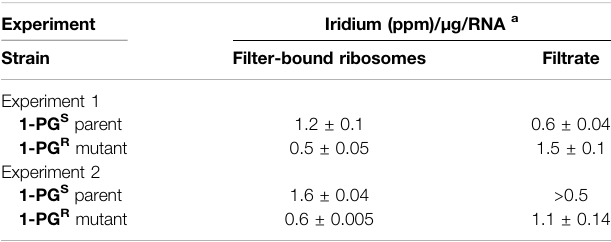
TABLE 3 | Iridium-binding of fi lter-bound ribosomes of 1-PG S M. smegmatis parent and 1-PG R mutant A1. The bold values are short form name of the antimycobacterial compound in Figure 1 , 1-PG